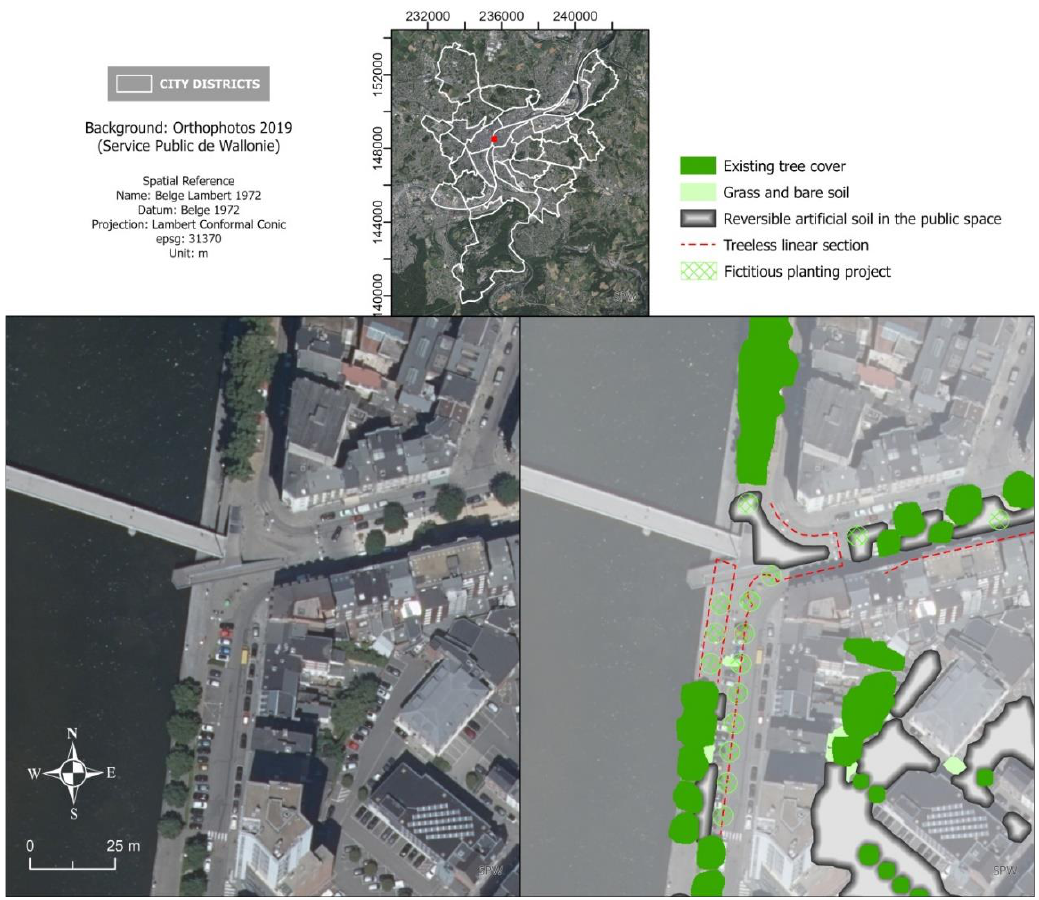
Figure 3. Illustration of the four cartographic products over the Quai Churchill area (Outremeuse district), i.e. existing tree cover, grass and bare soil, reversible artificialized soil in the public space and treeless road linear sections, and presentation of a fictitious planting